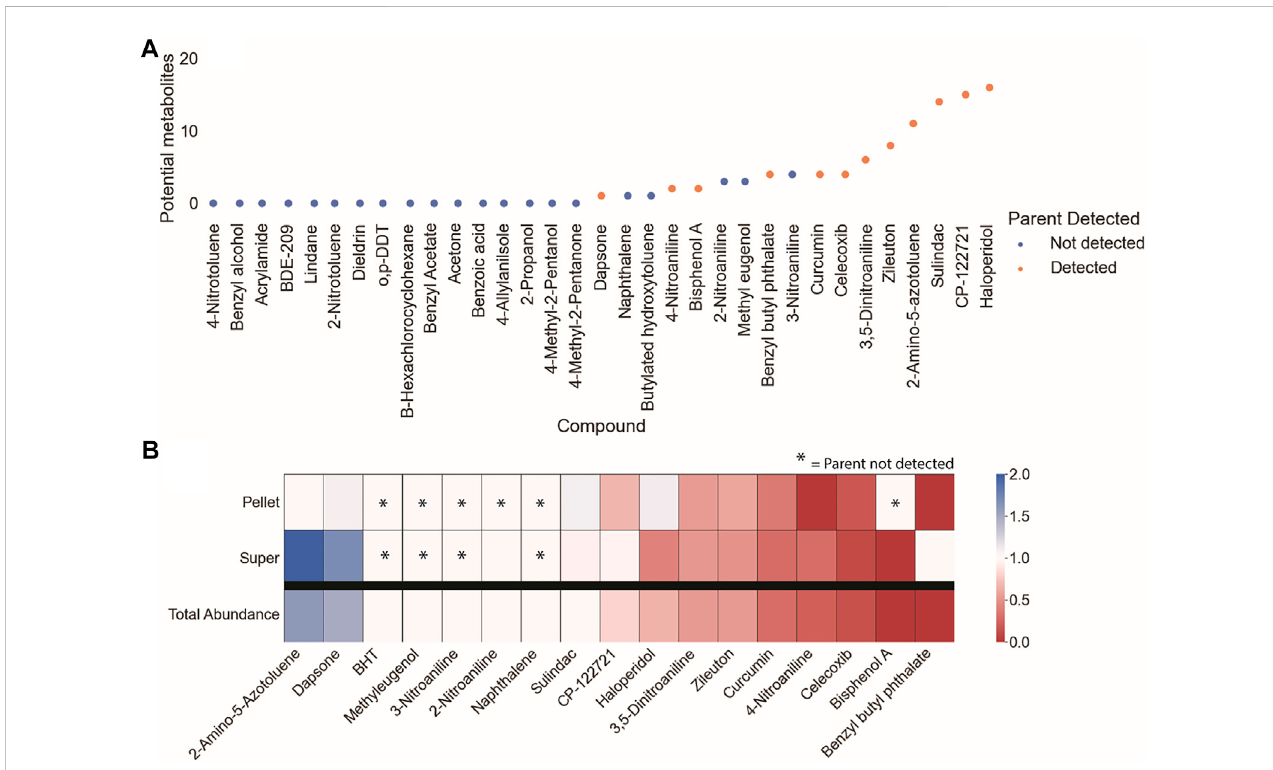
FIGURE 3 Preliminary survey of MS 1 data to prioritize data processing and analysis of parent compounds. EIC of the parent compounds were used to assess (A) whether theparent compound was detectable and thequantity ofpotential metabolites within that dataset, and (B)